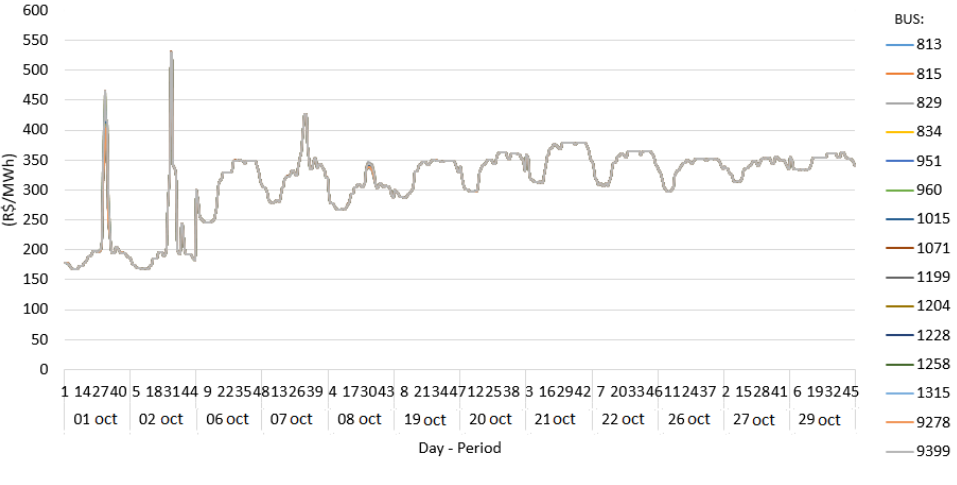
Figure 4. South BMC values on base case.